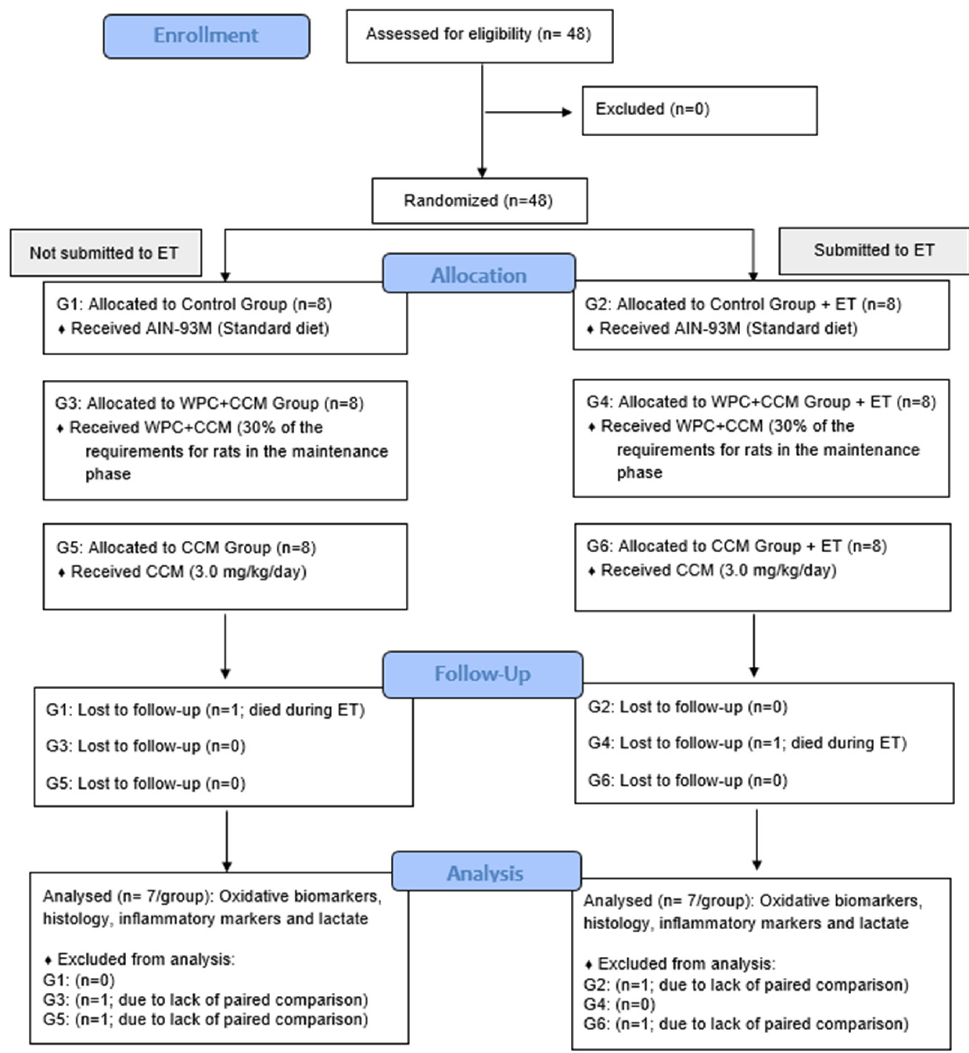
Figure 1. Flow diagram depicting the study design. AIN-93M: group that received a standard diet; WPC + CCM ET: group that received curcumin-added whey protein concentrate; CCM: group that received curcumin; ET: exhaustion test. Based on CONSORT [28].